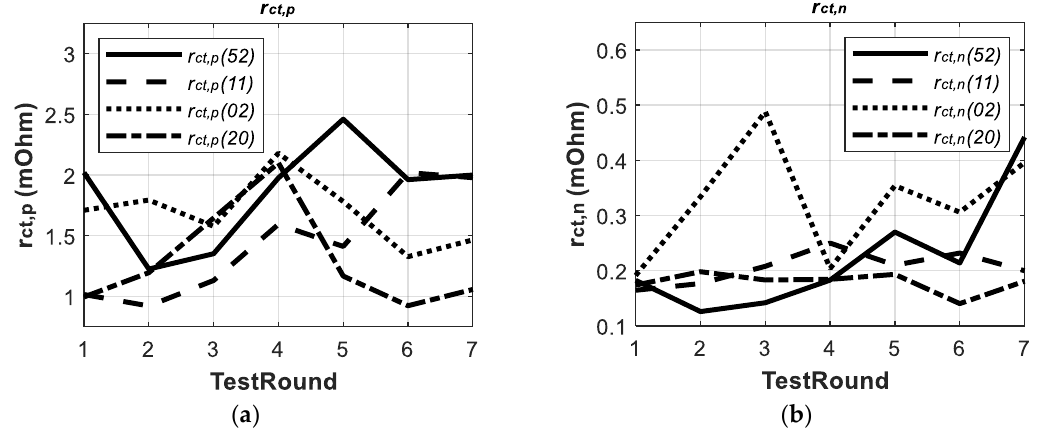
Figure 17. Characteristic charge-transfer resistances in FPLC ACequ : ( a ) r ct,p of positive electrode; ( b ) r ct,n of negative electrode. [29].